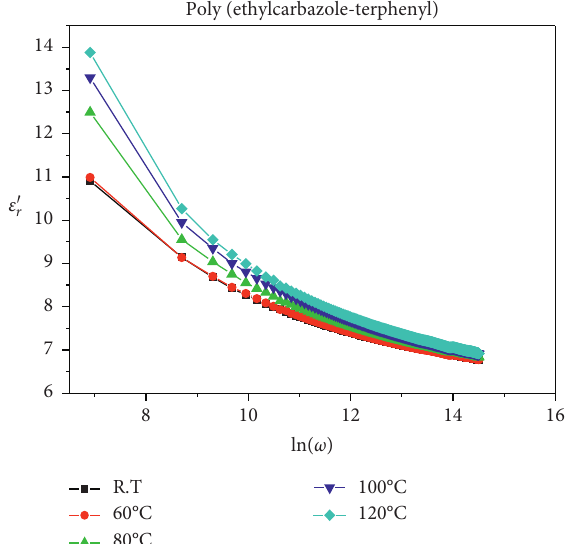
Figure 2: Dielectric constant vs. frequency of PEcbz-Ter at dif- ferent